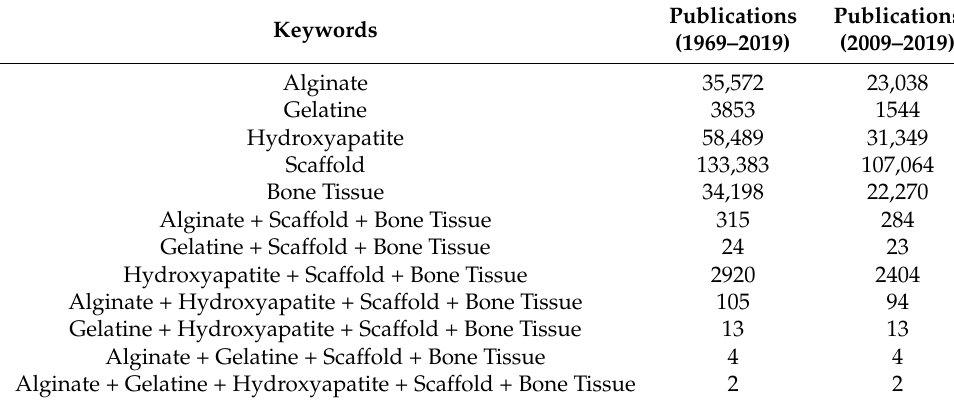
Table 1. Number of publications based on the Scopus database using keywords alginate, gelatine, hydroxyapatite, scaffold, bone